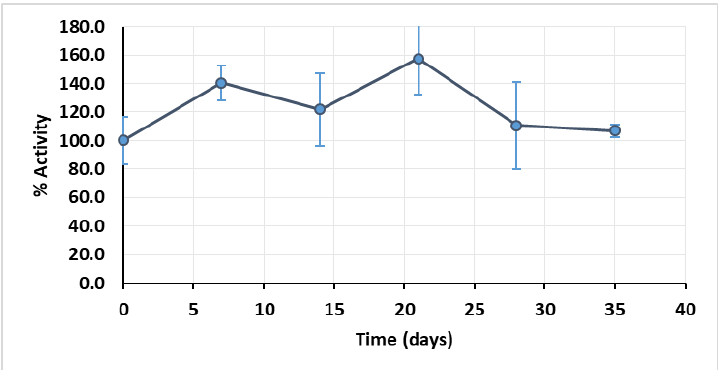
Figure 1. Curve of enzymatic extract stability when stored at −80 °C; pH 4.5. Error bars represent standard deviation.